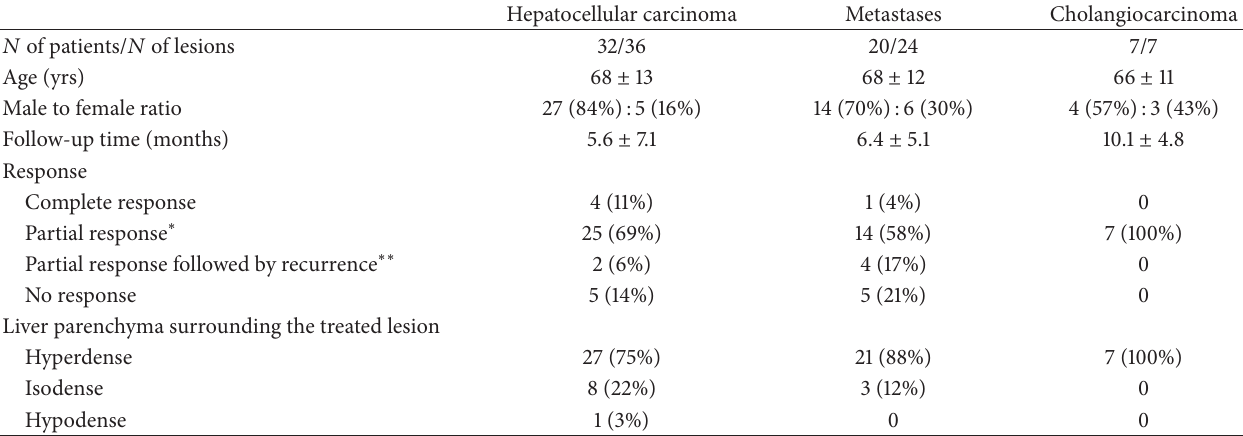
Table 1: Clinical characteristics and treatment response by the different groups of treated